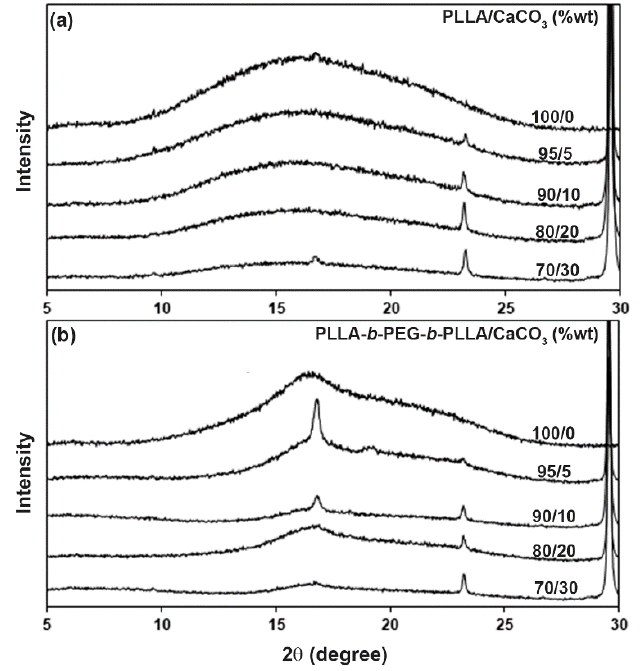
Figure 7. Expanded XRD patterns of ( a ) PLLA/CaCO 3 and ( b ) PLLA- b -PEG- b -PLLA/CaCO 3 com- posite films with various CaCO 3 ratios. Table 4. Crystallinity contents of the composite films from Figure